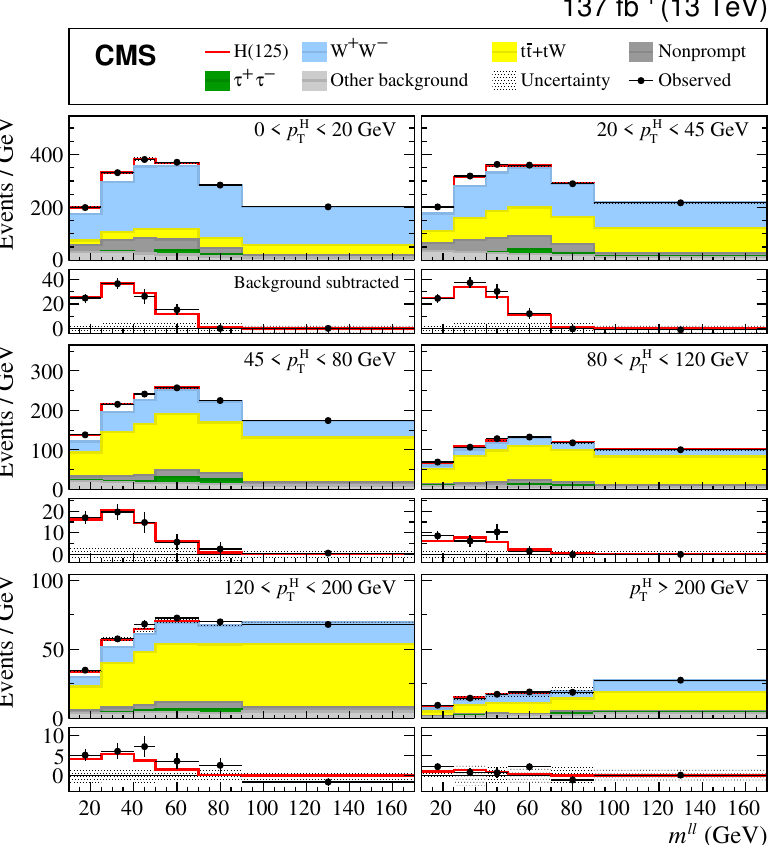
Figure 1 . Observed distributions of m ll in data and the expectations from the best fit model with the uncertainties. The distributions in each p H bin are given in separate panels. Within each panel, T the lower sub-panel displays background-subtracted observations and expectations.